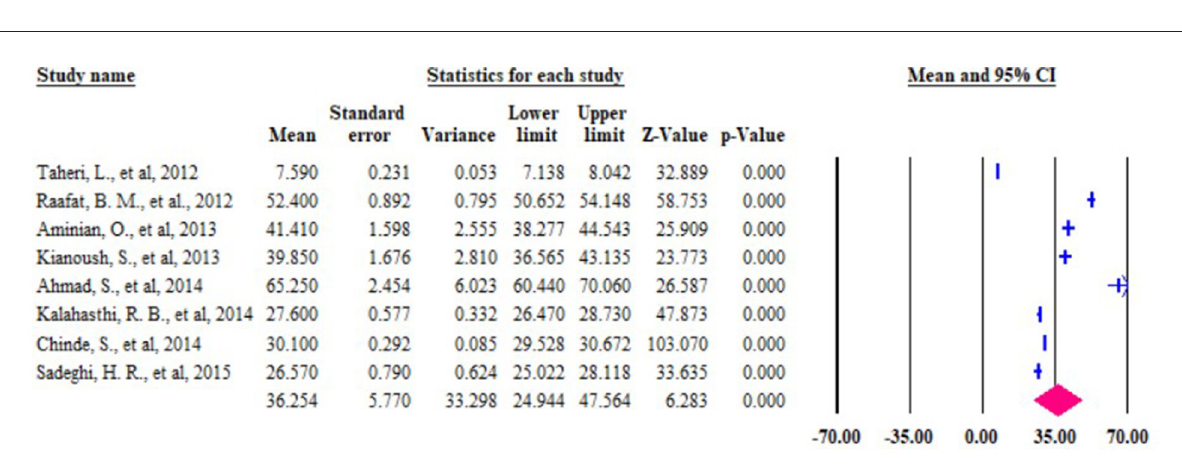
FIGURE4 Figure subgroup analysis by year of the publication of the mean of BLL among lead battery workers in LMIC, 2022 ( n = 18).